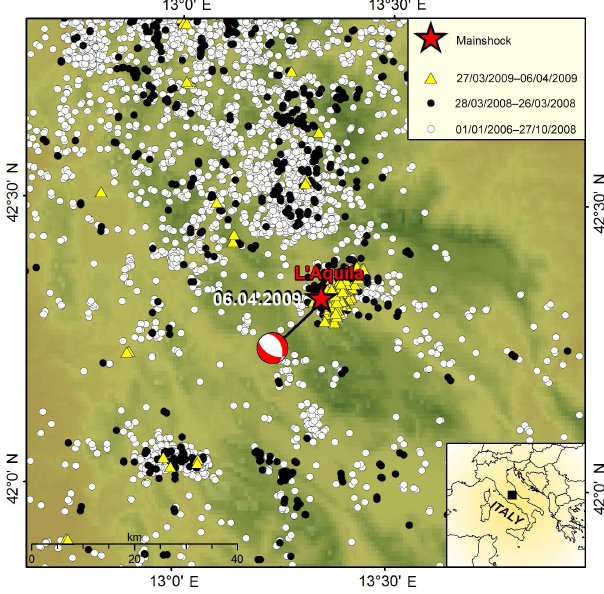
Figure 1. Epicentral distribution of earthquakes in the area of L’Aquila for the time interval extending from 1 January 2006 to 6 April 2009. The focal mechanism of the L’Aquila mainshock (star) was calculated by INGV. Note the dense concentration of foreshock epicenters close to the mainshock epicenter in the last 10 days pre- ceding the mainshock occurrence, which indicates that foreshocks moved towards the mainshock nucleation